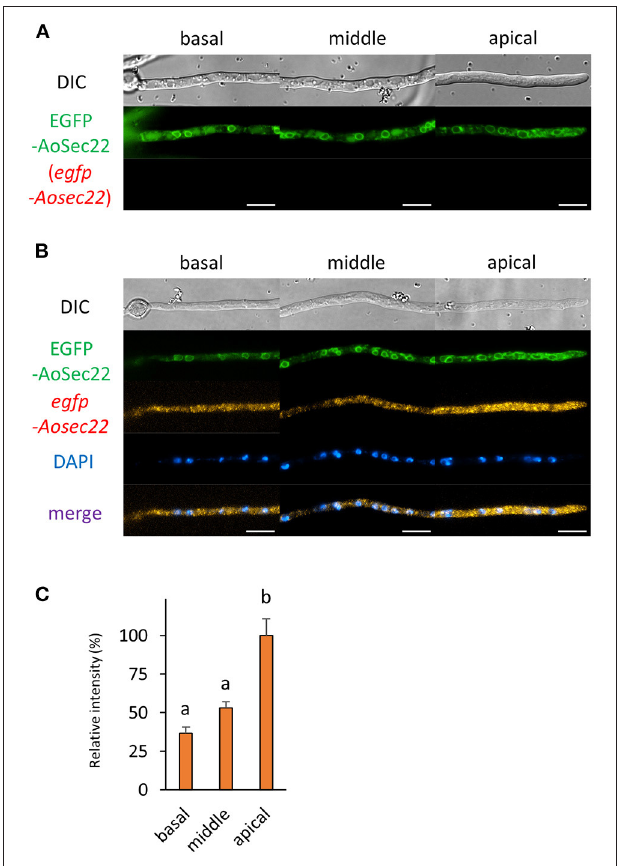
FIGURE 6 | The fluorescence derived from EGFP-AoSnc1 protein and egfp-Aosnc1 mRNA was observed in hyphal cells of the EGFP-AoSnc1-expressing strain. (A) EGFP-AoSnc1 was observed in live cells. (B) smFISH with egfp probe resulted in the observation of the fluorescence of EGFP-AoSnc1 and egfp-Aosnc1 mRNAs. Nuclei were stained with DAPI. Bars, 10 µ m. (C) Relative fluorescence intensity of egfp-Aosnc1 mRNA was determined at apical, middle, and basal cells. Bars show mean with standard error ( n = 10